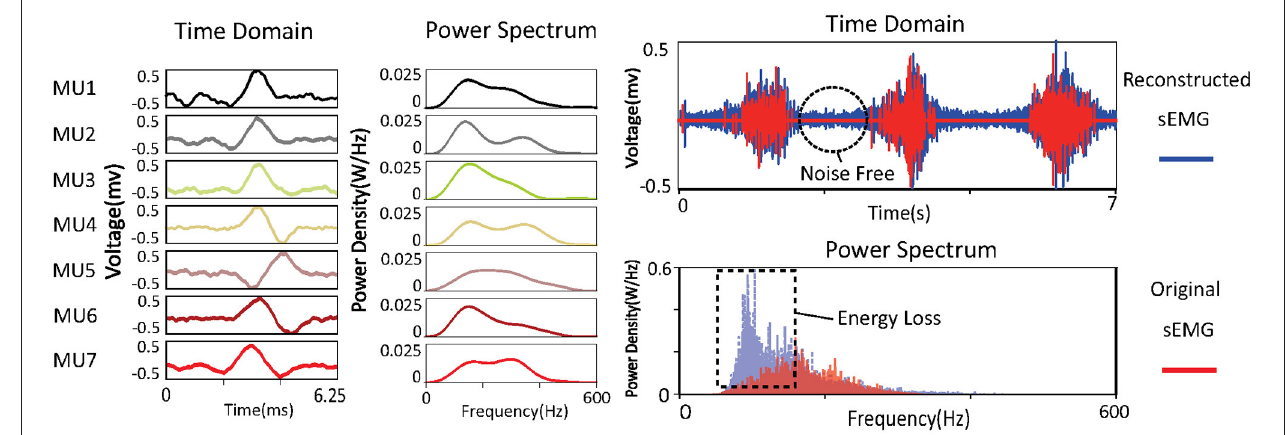
FIGURE 6 | Time domain and power spectra of MUAPs and sEMG signals.